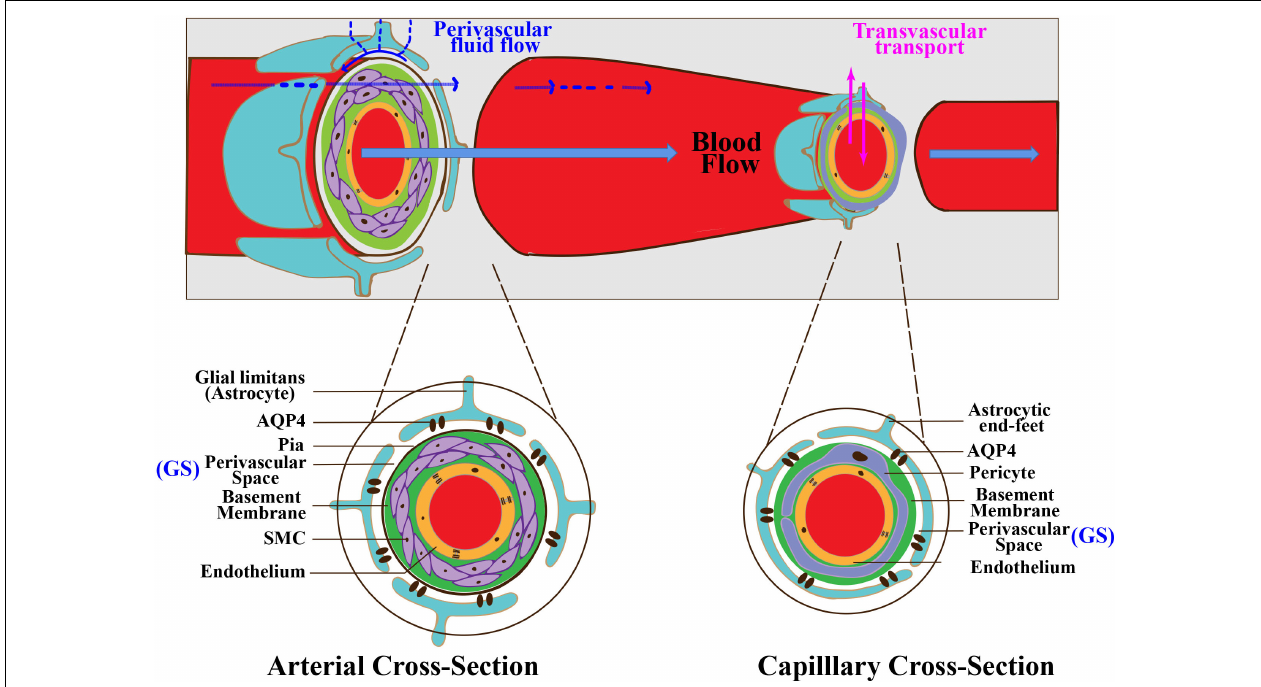
FIGURE 2 | Interaction between the GS and the BBB. The GS is anatomically and functionally interconnected with the BBB. There is some overlap in anatomical structures between the BBB and the GS. At the arterial level (left inset), endothelial cells form the inner layer of the vascular wall. The basement membrane separates endothelium from SMCs. The basement membrane and SMCs are enveloped by the pia. The PVS is between the pia and the glia limitans formed by astrocytic end-feet. At the capillary level (right inset), pericytes and endothelial cells share a basement membrane. The PVS is between the basement membrane and astrocytic end-feet. The BBB regulates the exchange of molecules between the blood and the brain tissue via multiple transport systems. The GS regulates the exchange of fluid and solutes between the CSF and the ISF. GS, glymphatic system; BBB, blood–brain barrier; PVS, perivascular space; SMCs, smooth muscle